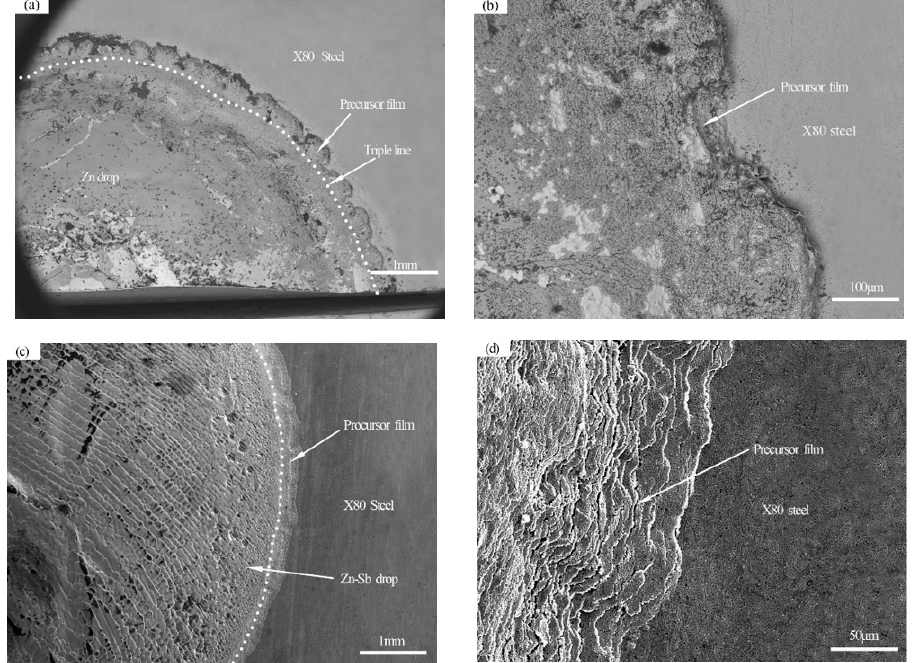
Figure 3. Surface morphology of Zn and Zn-1.0 wt. % Sb and X80 steel after wetting: ( a ) macro image of Zn/X80 steel sample; ( b ) micro image of Zn/X80 steel precursor film; ( c ) macroscopic image of Zn-1.0 wt. % Sb/X80 steel sample; ( d ) microscopic image of Zn-1.0 wt. % Sb/X80 steel precursor film.